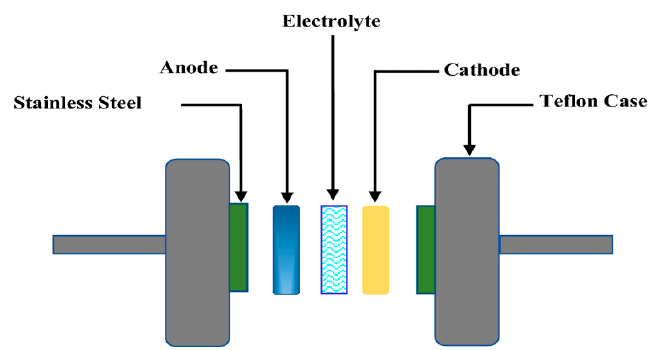
Figure 2. Schematic illustration for the CV and supercapacitor measurements. Adapted from